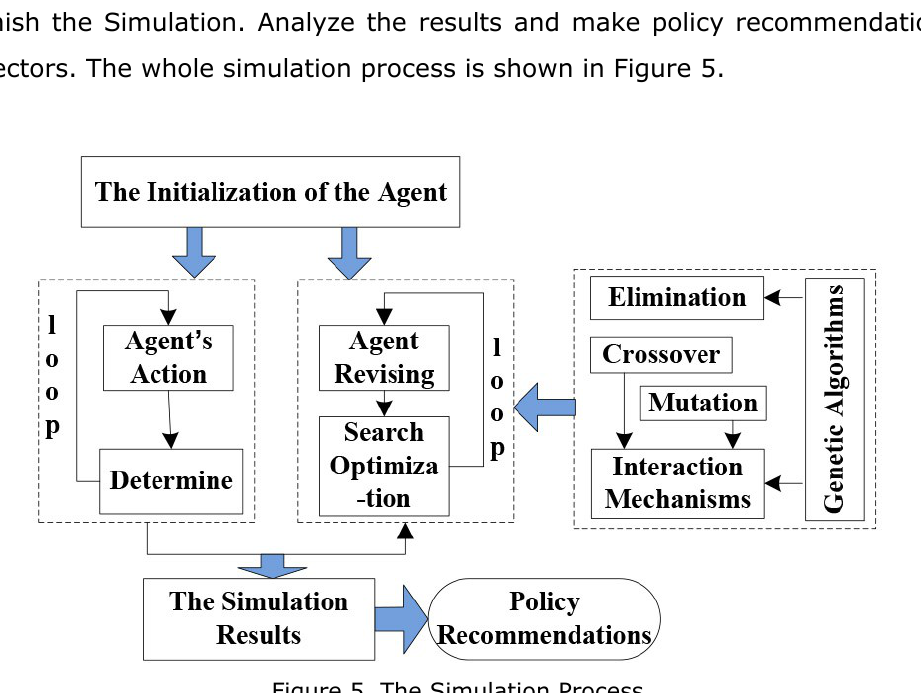
Figure 5. The Simulation